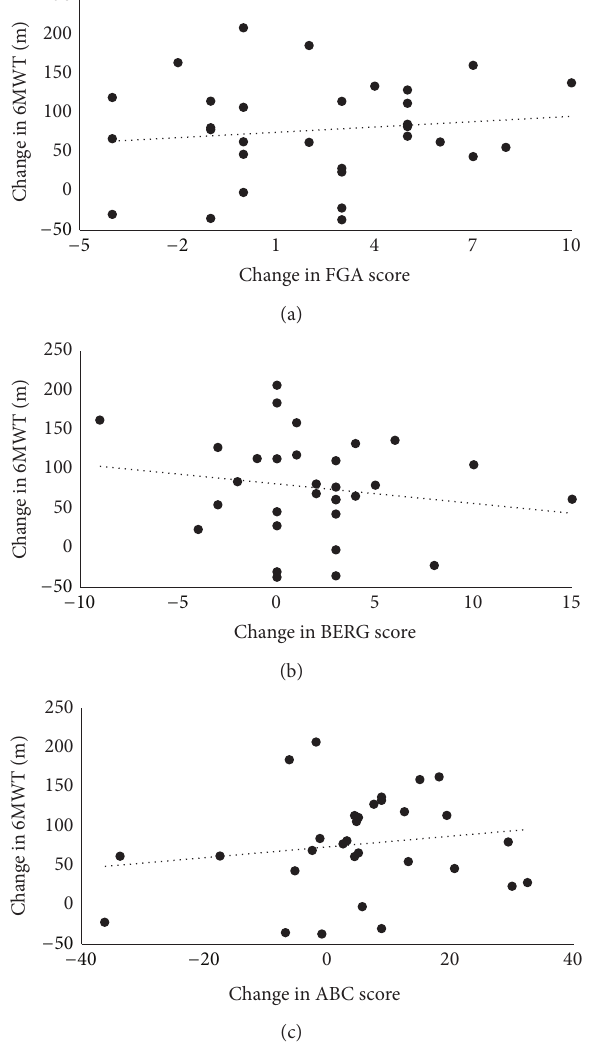
Figure 2: Scatter plots presenting the relationships between changes in long-distance walking function (6MWT) versus changes in walking balance (functional gait assessment (FGA), panel (a)), standing balance (Berg Balance Scale (BERG), panel (b)), and balance self-efficacy (Activities Specific Balance Confidence (ABC) Scale, panel (c)). Even though each balance variable was strongly related to 6MWT performance at baseline (Figure 1), no significant change relationships were